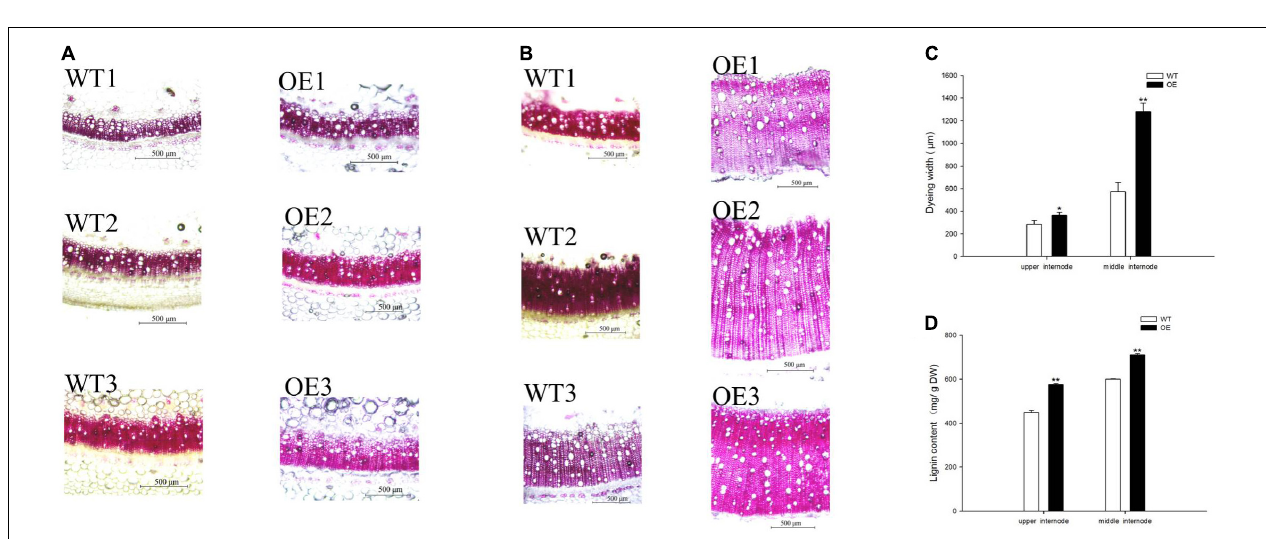
FIGURE 4 | PpCCoAOMT overexpression increases xylem vessel proliferation and expansion. (A) Representative upper internode cross-sections of WT and OE plants stained with Wiesner stain. Bars = 500 µ m. (B) Representative middle internode cross-sections of WT and OE plants stained with Wiesner stain. Bars = 500 µ m. (C) The dye widths of the WT and OE transgenic tobacco lines were determined using Image-Pro Plus 6.0 software. Data are means ( ± SDs) of nine replicates. Each replicate was measured three times at different angles. (D) Lignin content in WT and OE plants. Data are means ( ± SDs) of triplicates Significant differences between WT and OE lines were determined using independent samples t- tests. * P < 0.05, ** P <